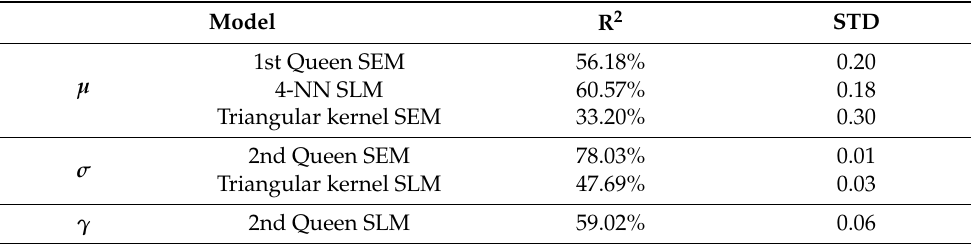
Table 4. Summary of the R 2 and standard deviation of models with significant spatial coefficient ( p -value < 0.05).